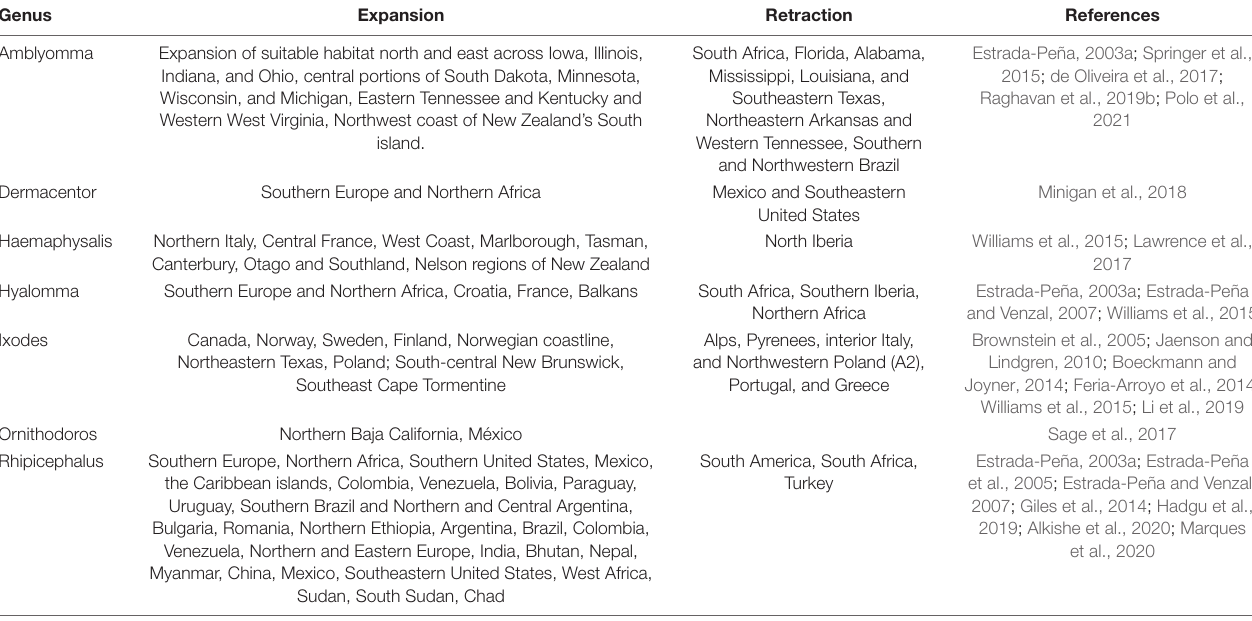
TABLE 5 | Expected expansion and retraction of tick genera habitat based on future climate variables projections for various